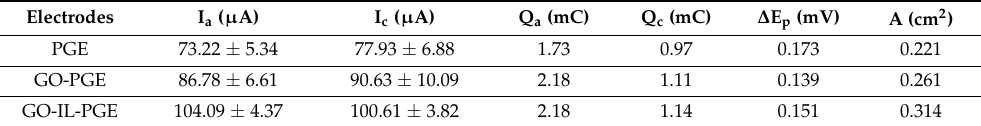
Figure 3. The average I a values ( n = 3) measured by ( a ) PGE and ( b ) GO-PGE and GO-IL-PGE in the presence of IL composition as ( c ) 2.5 %, ( d ) 5 %, ( e ) 7.5 %, and ( f ) 10 %. Inset: CVs recorded by PGE, GO-PGE, and GO-IL-PGE in the presence of an IL composition of 7.5 %. Table 2. The average values ( n = 3) of anodic and cathodic peak currents (I a, I c ), relative anodic and catodic charge (Q a, Q c ), and Δ E p values and electroactive surface areas (A) for PGE, GO-PGE, and GO-IL-PGE (in case of 7.5 % IL concentration).